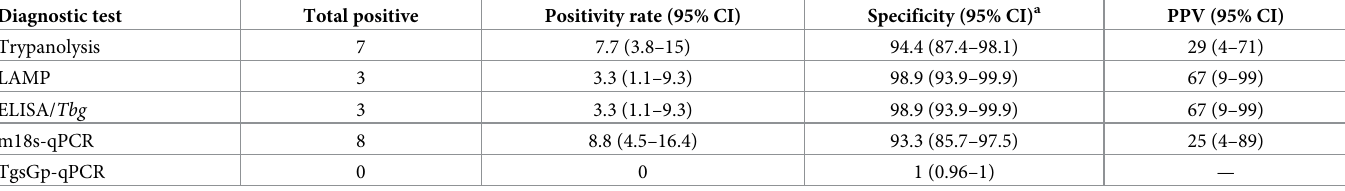
Table 4. Performance of laboratory tests performed on dried blood spots of RDT seropositive subjects for diagnosis of HAT, using the parasitological test as gold